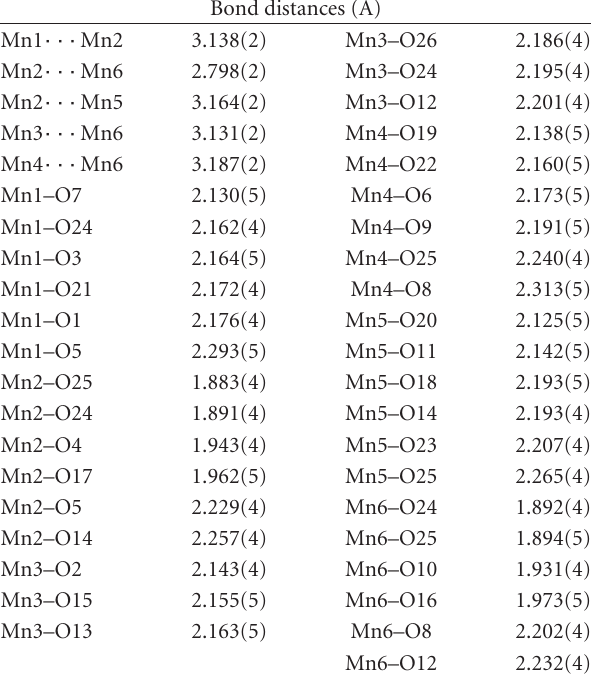
Table 2: Selected interatomic distances ( ˚A) for complex ( 1 · 2.5H 2 O) ∞ .